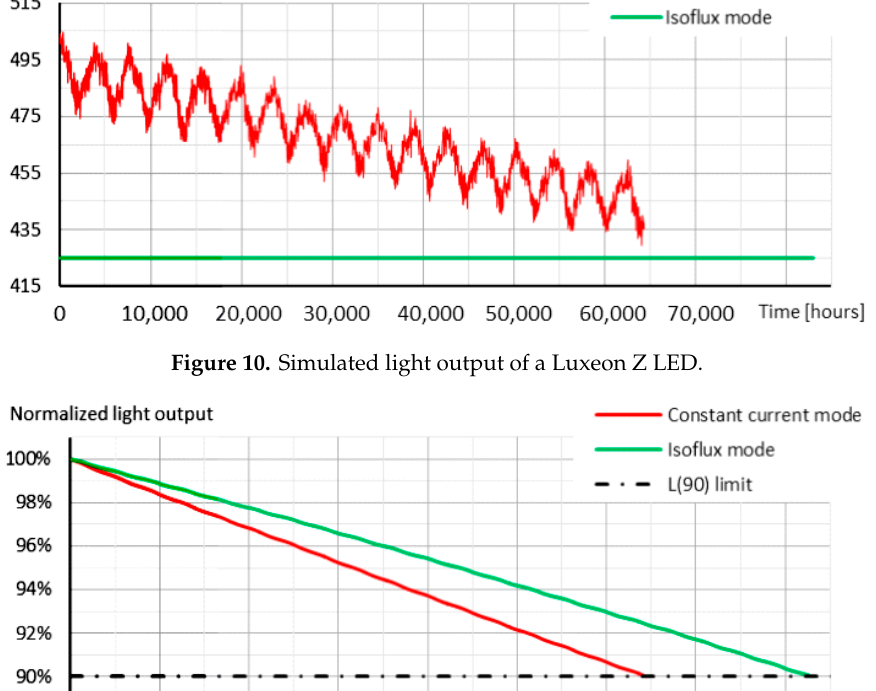
Figure 9. The forward currents applied during the simulation (the absolute maximum DC forward current of the Luxeon Z LEDs is 1 A).